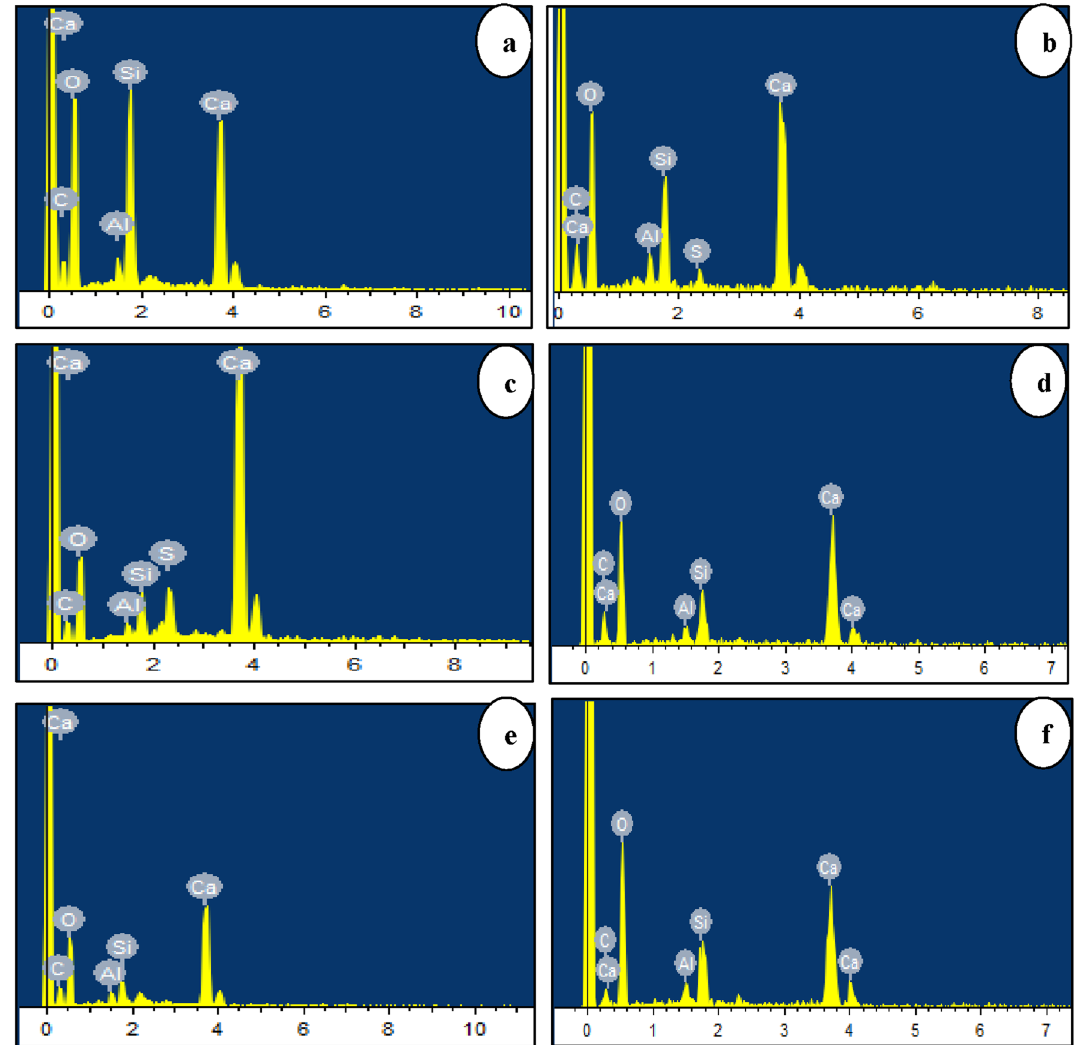
Figure 14. EDX images compared between ( a ) FCB with 1300 kg/m 3 , ( b ) B-FCB with 1300 kg/m 3 , ( c ) FCB